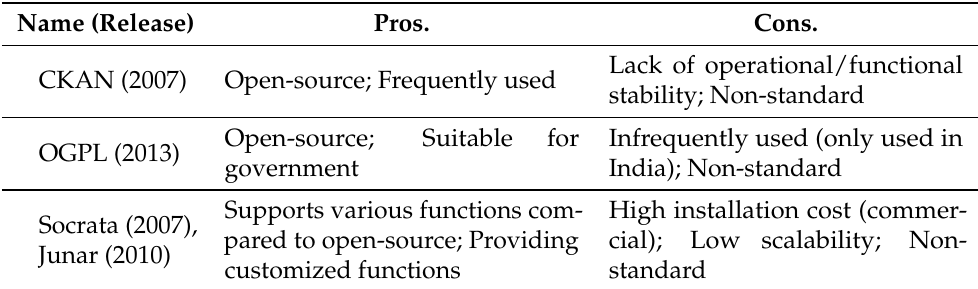
Table 2. Pros and cons of existing open data platforms.